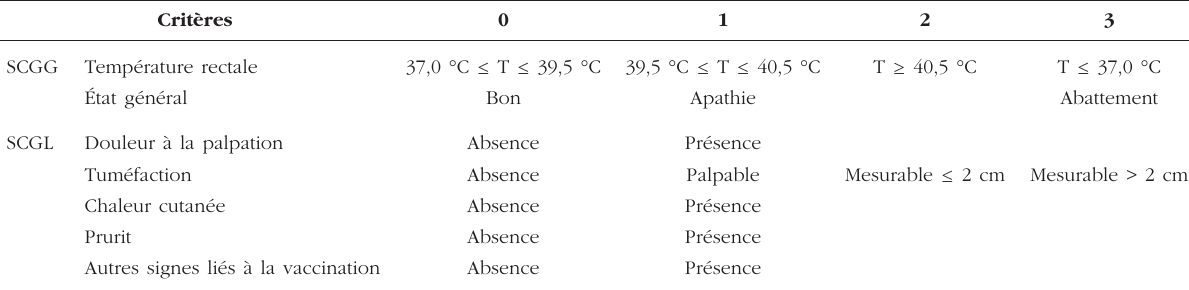
Tableau I. – Grille de cotation des Score clinique global général (SCGG) et Score clinique global local